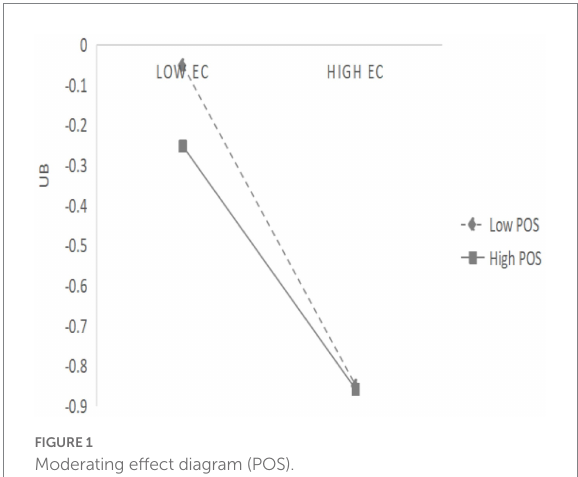
FIGURE 1 Moderating effect diagram